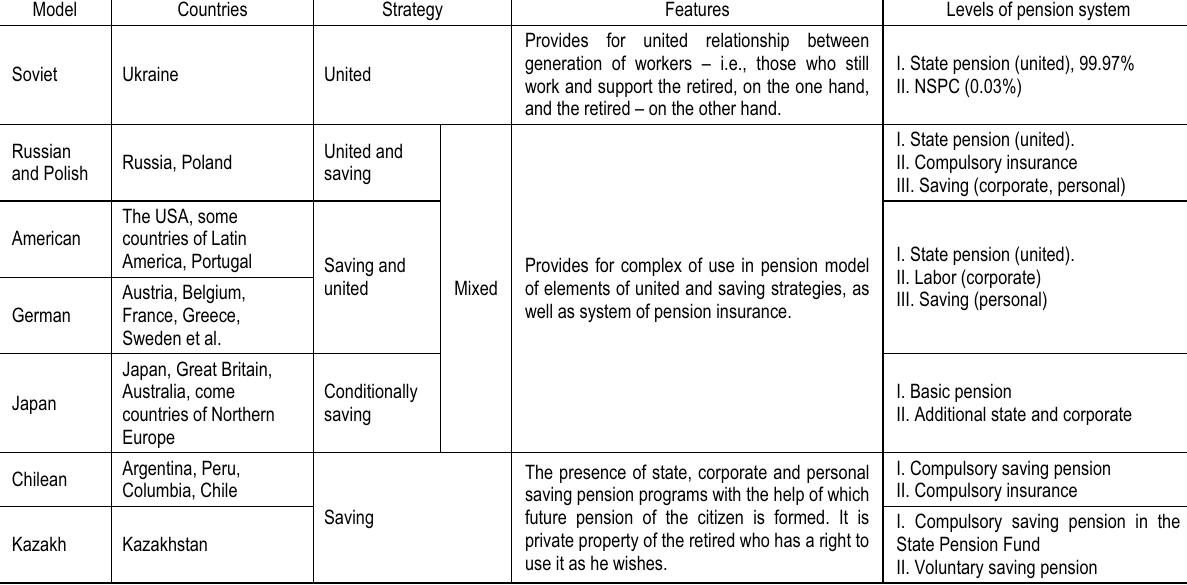
Table 1. Models of pension coverage according to strategies of development Model Countries